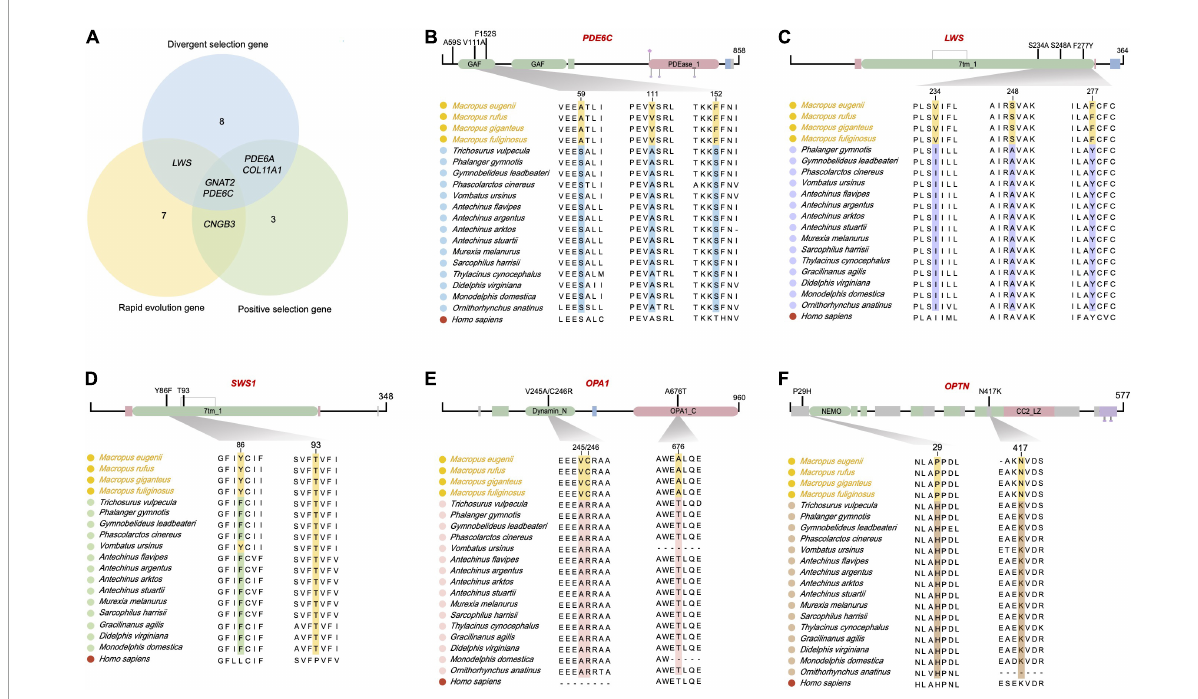
FIGURE5 Five retinal phototransduction proteins have fixed amino acid substitutions in the crepuscular genus Macropus . (A) Venn graph of positively selected genes, rapidly evolving genes, and divergently selected genes in genus Macropus . (B–F) Proteins with fixed amino acid substitutions in Macropus . PDE6C (phosphodiesterase 6C, cGMP-specific, cone, and alpha prime), LWS (long wavelength-sensitive opsin), SWS1 (short wavelength-sensitive opsin 1), OPA1 (OPA1 mitochondrial dynamin-like GTPase), and OPTN (optineurin). Top, overview of amino acid